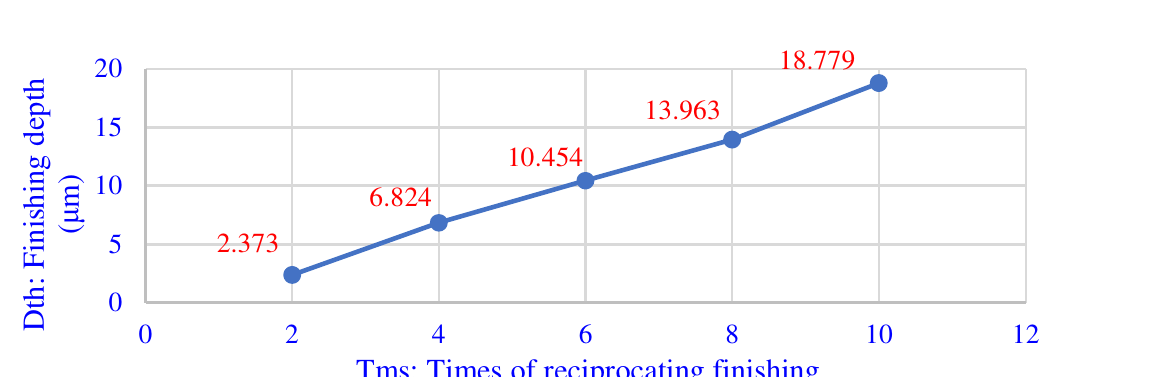
Figure 12. The relationship between reciprocating times and processing depth.